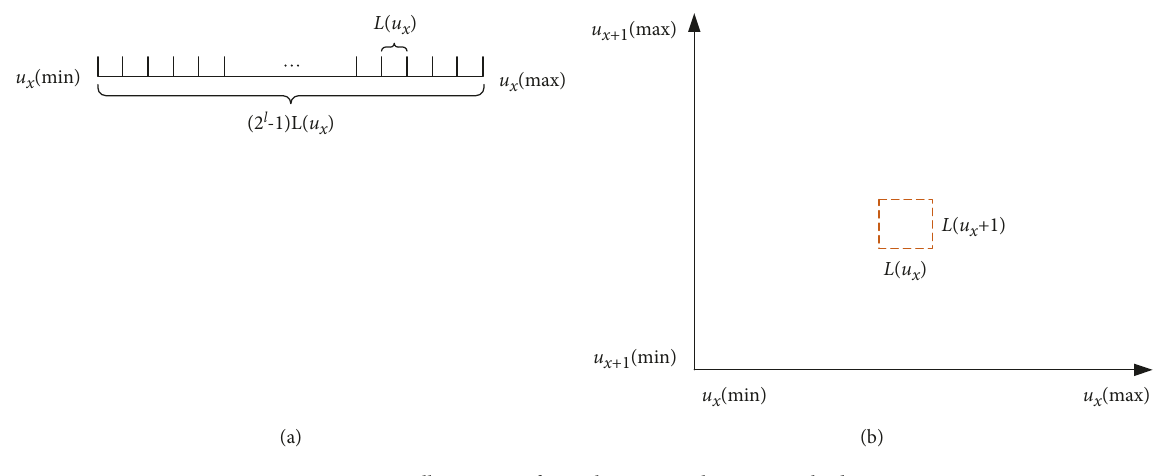
Figure 2: Illustration of population initialization method.